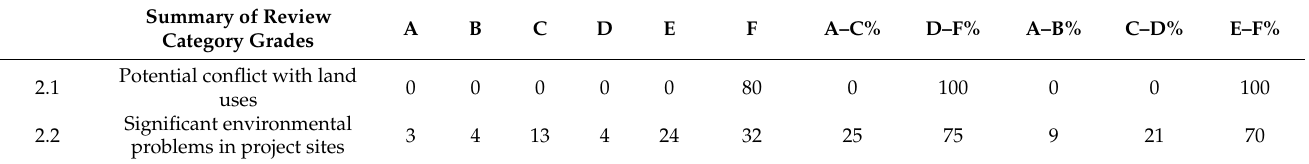
Table 6. Allocation of quality to environmental assessment tasks performed under Review Area 2.